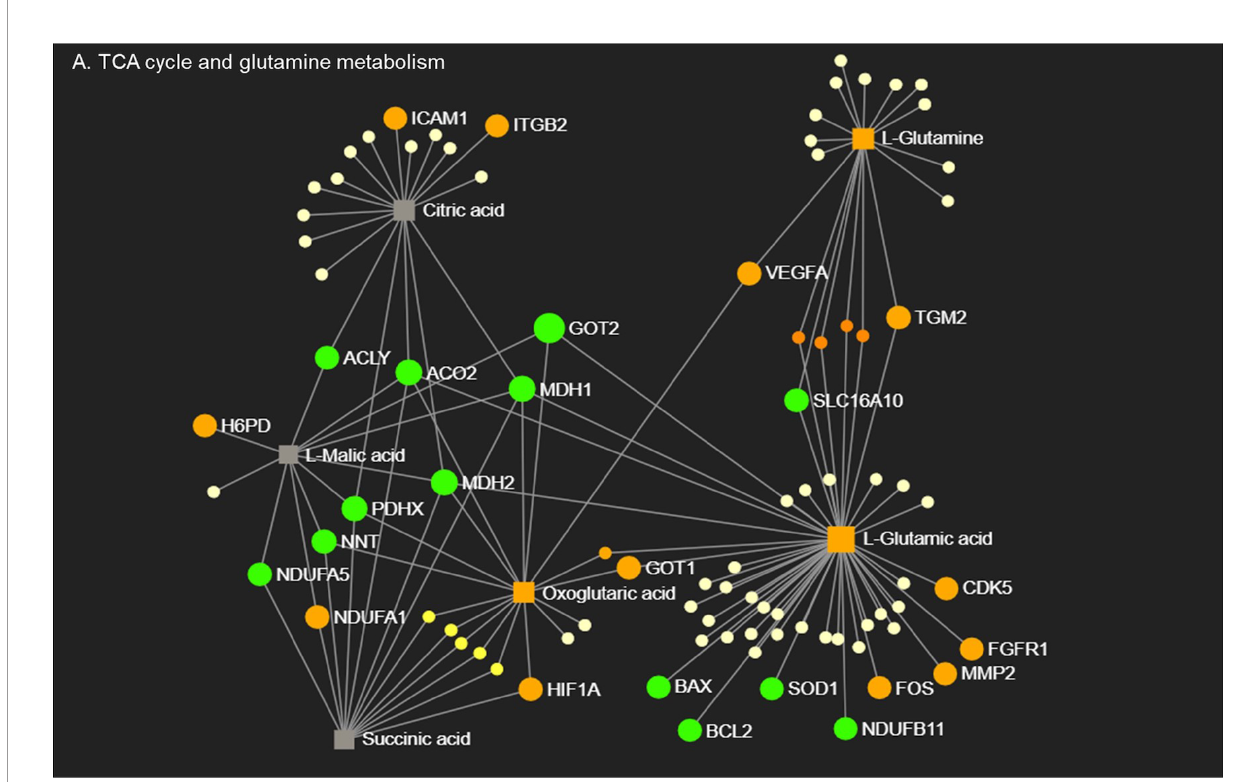
FIGURE 4 | Macrophages respond to PH-CM through an integrated transcriptional and metabolic network. Metabolites in TCA cycle and glutamine metabolism pathways detected in PH-CM treated vs. untreated BMDMs by mass spectrometry were combined with differentially expressed genes ( p ≤ 0.05) from RNA-seq analysis to generate gene-metabolite network pathways using Metaboanalyst Network Explorer (www.metaboanalyst.ca). Genes and metabolites with established functions in macrophage phenotype are identi fi ed and their node symbols are colored based on their levels in PH-CM treated BMDMs compared to untreated BMDMs. Orange circle: increased genes. Green circle: decreased genes. Orange Square: increased metabolites. Grey Square: genes or metabolites not signi fi cantly changed in response to PH-CM. Yellow circles: genes or metabolites not known to be signi fi cant in macrophage phenotypes. The size of the nodes is arbitrary and does not signify